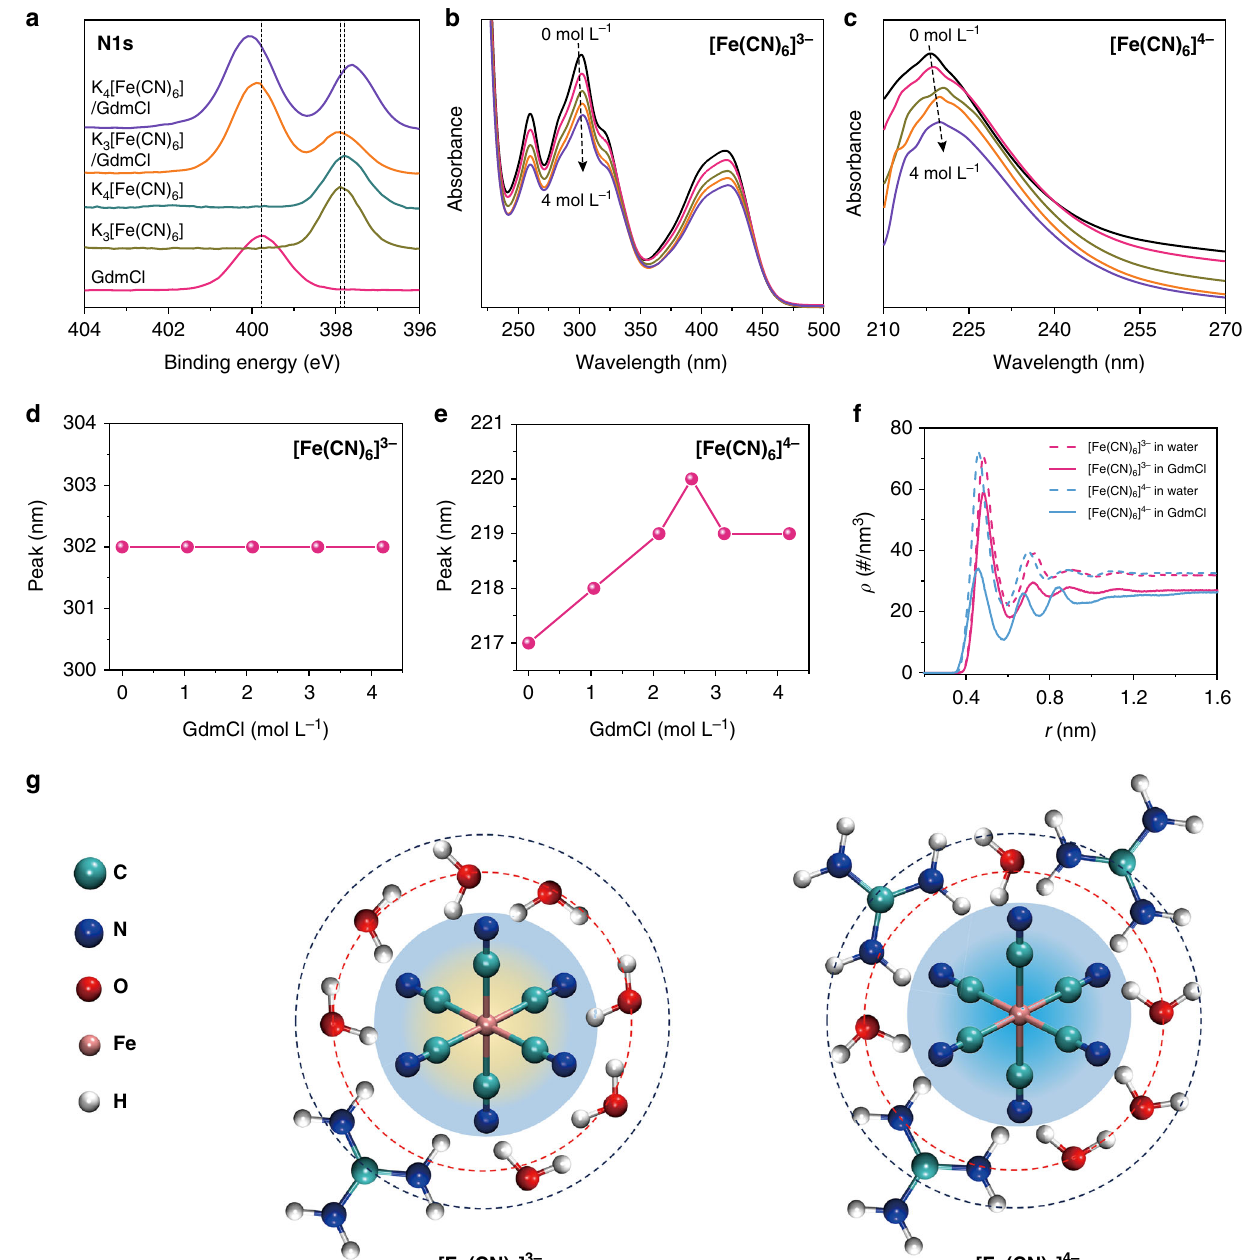
Fig. 2 The mechanism of enhancement of the Seebeck effect by GdmCl. a XPS spectra shift for K 3 [Fe(CN) 6 ], K 4 [Fe(CN) 6 ], GdmCl, and their composites. For the composites, GdmCl at an optimized concentration of 2.6 M was added to 0.4 M K 3 [Fe(CN) 6 ] or K 4 [Fe(CN) 6 ]. The solid samples used for XPS measurement were prepared by drying the composite solutions in a vacuum oven at 333 K for 48 h. UV – Vis spectral shifts and the